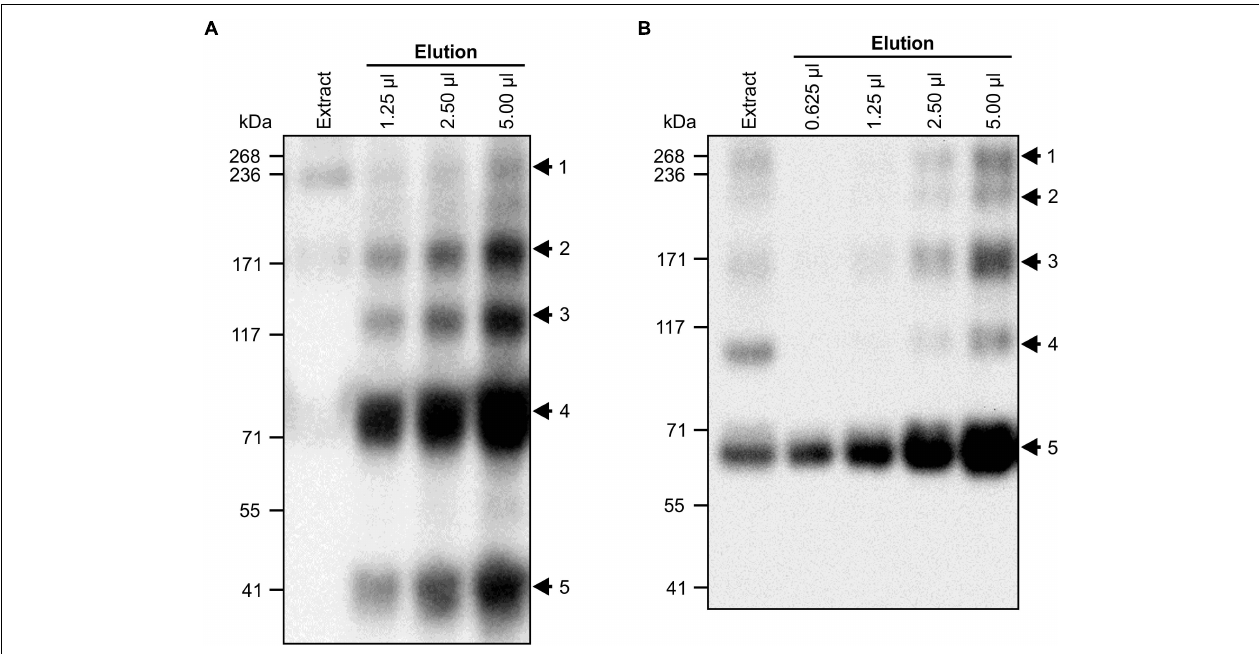
FIGURE 5 | Vacuum infiltration and purification of V H H9-sIgA. N. benthamiana leaves were vacuum infiltrated with a mixture of V H H9-Fc/SC/JC and p19. Tissue was collected at 12 dpi. Cell extracts were prepared under native conditions and separated with SDS-PAGE under non-reducing conditions. (A) Secretory IgA was purified with peptide M Agarose. Western blots were detected with anti-c-Myc antibody. Arrows indicate the expected size of fully assembled sIgA (No. 1), tetrameric (No. 2, ∼ 176 kDa), trimeric (No. 3, ∼ 132 kDa), dimeric (No. 4, ∼ 88 kDa), and monomeric (No. 5, ∼ 44 kDa) V H H9-Fc. (B) Secretory IgA was purified with anti-FLAG agarose. Western blots were detected with anti-Flag antibody. Arrows indicate the expected size of fully assembled sIgA (No. 1, ∼ 66 kDa), SC/trimeric V H H9-Fc/JC (No. 2, ∼ 206 kDa), SC/dimeric V H H9-Fc (No. 3, ∼ 160), SC/monomeric V H H9-Fc (No. 4, ∼ 110 kDa), and monomeric SC (No. 5). 10 µ l of cell extract was loaded as a snapshot of the antibody produced in vivo